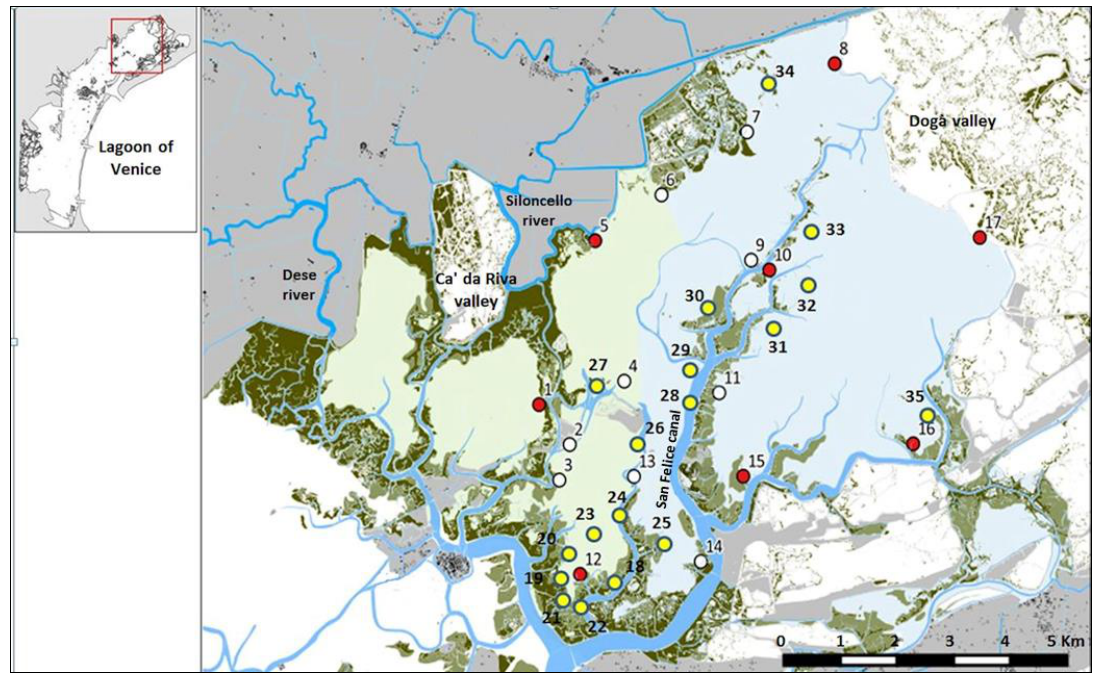
Figure 1. Map of the sampling area with the 35 transplanting stations. In red and white, the 17 stations transplanted in spring 2014. The stations in red were monitored monthly for one year for environmental parameters. In yellow, the 18 stations transplanted in spring 2015.